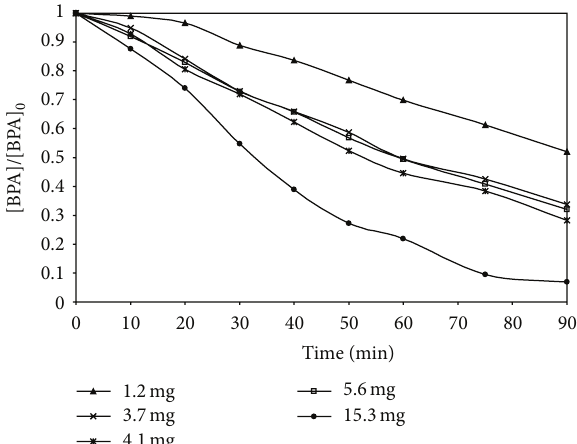
Figure 6: Effect of ZnO loading on the conversion of 100 𝜇 g/L BPA in